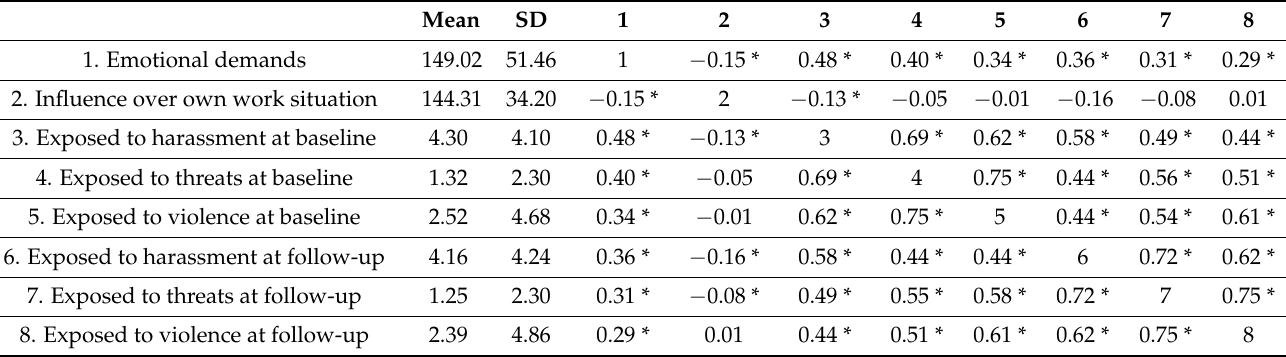
Table 2. Mean, standard deviation, and correlation of variables.